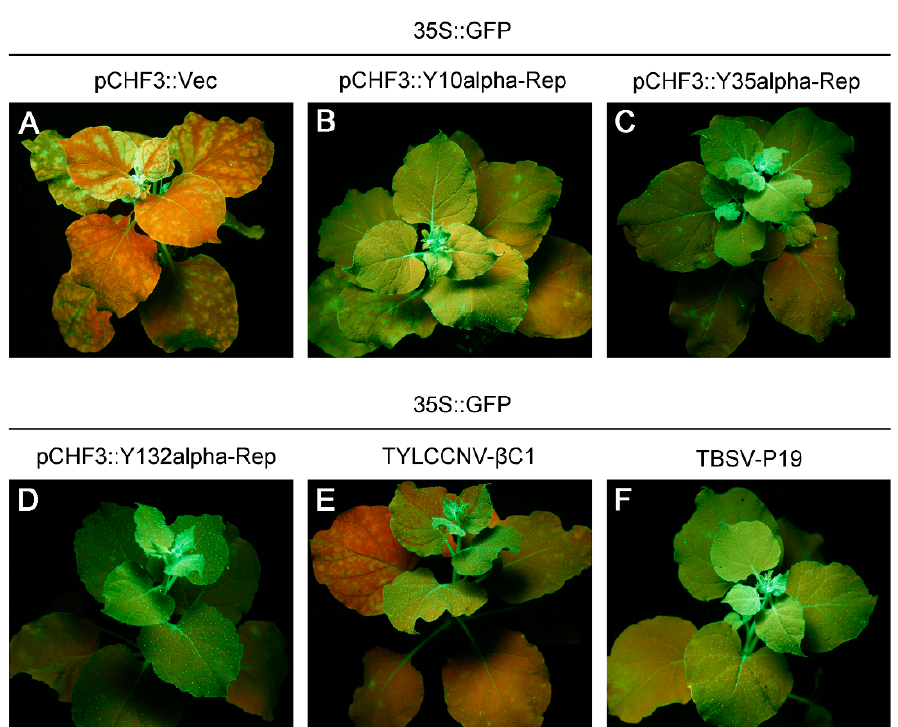
Figure 3. Alpha-Reps suppress the post-transcriptional gene silencing (PTGS) of systemic GFP. GFP fluorescence observed in transgenic N. benthamiana 16c plants agroinoculated with 35S::GFP plus pCHF3::Vec ( A ) pCHF3::Y10alpha-Rep ( B ) pCHF3::Y35alpha-Rep ( C ) pCHF3::Y132alpha-Rep ( D ) TYLCCNV-βC1 ( E ) or TBSV-P19 ( F ) at 30 days post infiltration (dpi). Leaves of 16c plants coagroinfiltrated with 35S::GFP plus pCHF3::Vec were used as the negative control and leaves of 16c plants coagroinfiltrated with 35S::GFP plus TYLCCNV-βC1 or TBSV-P19 were used as the positive controls.